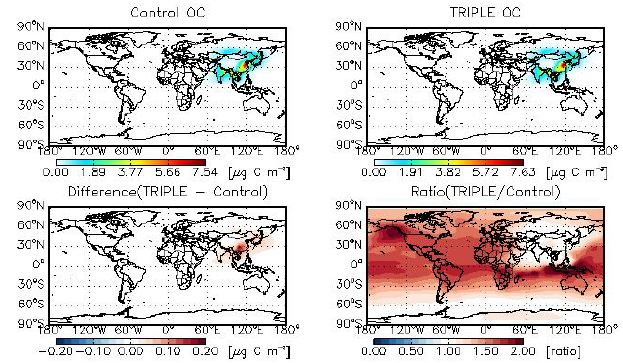
Fig. 11b. Same as Fig. 11a but for OC.